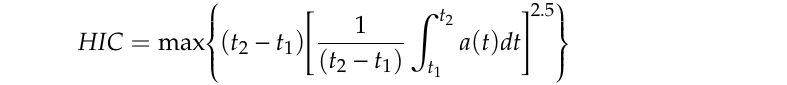
Figure 7. New FE model with modified belt.